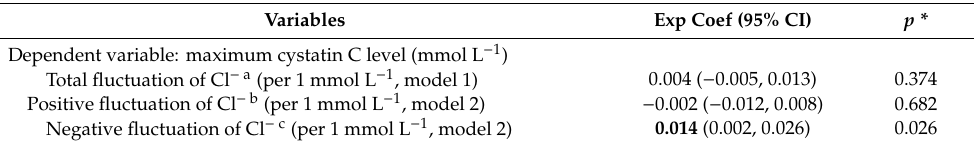
Table 5. Generalized linear regression model for maximum cystatin C level within 72 h after ICU admission according to fluctuation of Cl − ( n =